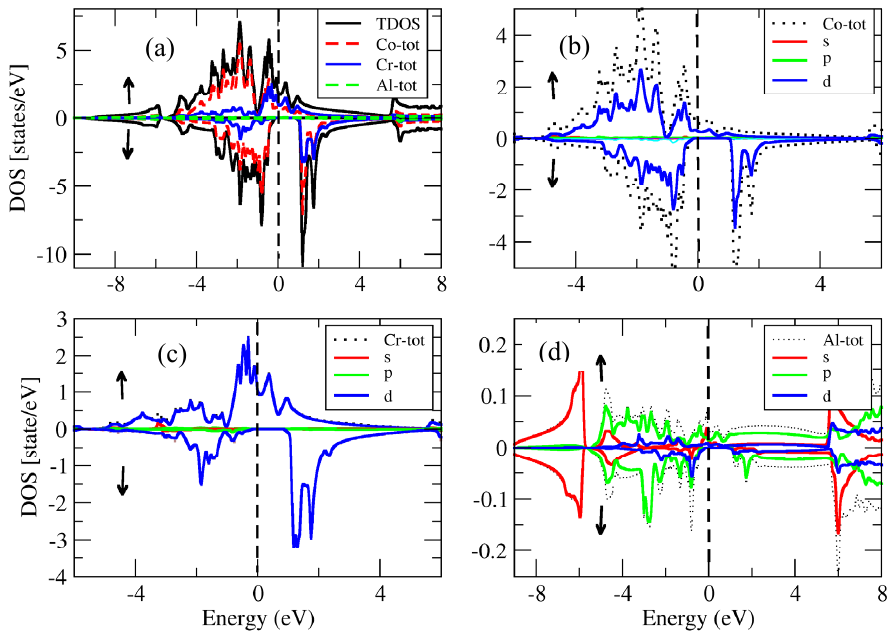
Figure 15. ( a ) Total density of states for the conventional Co 2 CrAl compound and the partial density of states for ( b ) Co atom, ( c ) Cr atom and ( d ) Al atom.